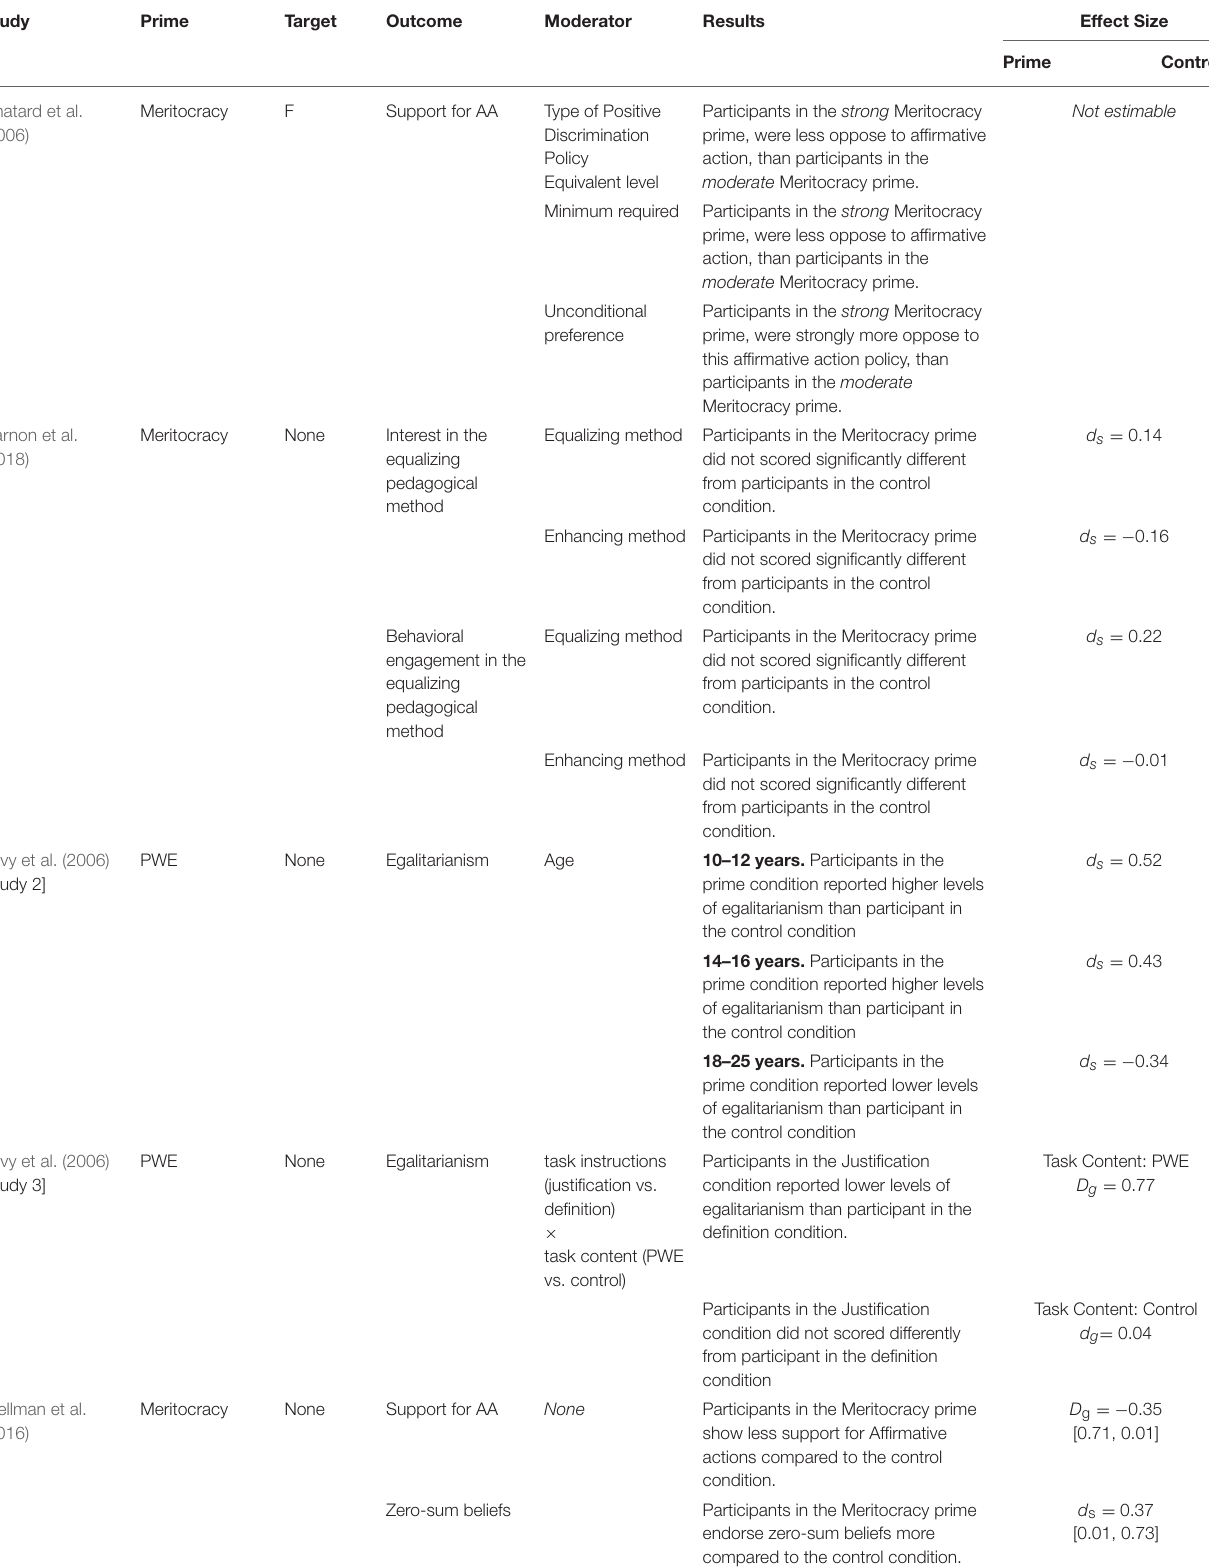
TABLE 3 | Summary of studies related with the Impact of Meritocracy and Equality between